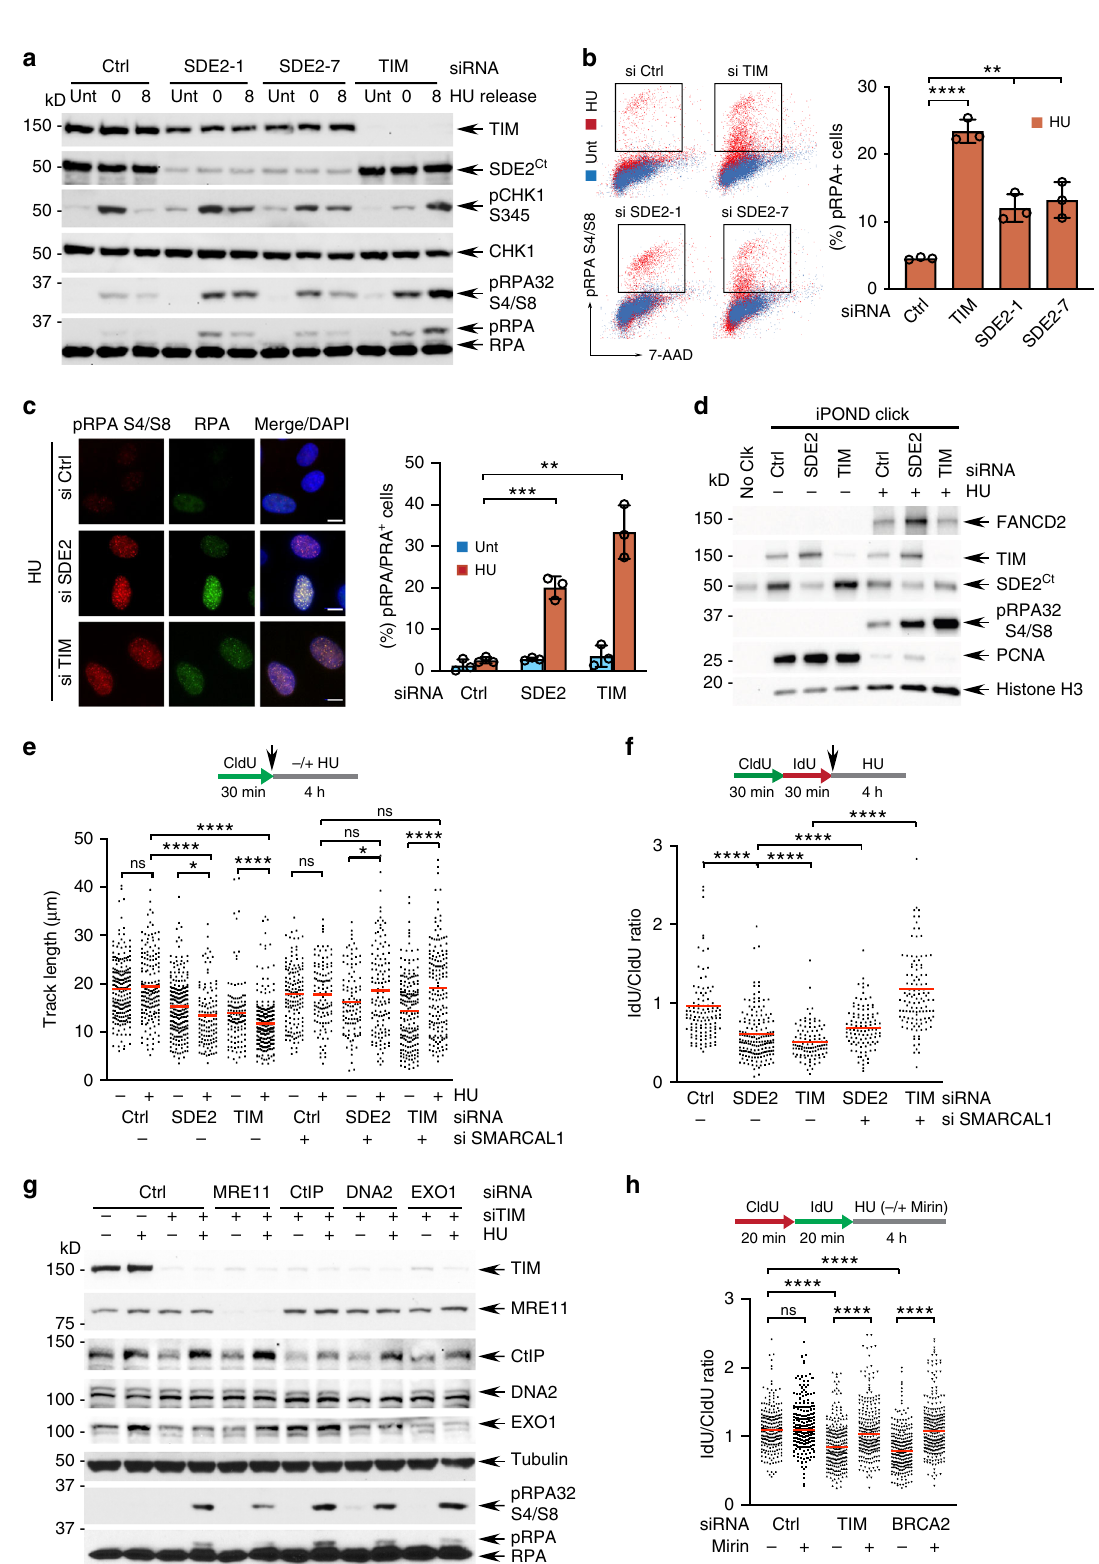
TIM function in preserving fork integrity. Subcellular fractiona- tion experiments showed that SDE2 WT complementation is able to rescue decreased TIM levels in the chromatin after SDE2 knockdown, while Δ SDE2 domain deletion mutant fails to do so (Fig. 7b; Supplementary Fig. 7a). Accordingly, a TIM-EdU PLA assay revealed that the Δ SDE2 mutant was not able to sustain